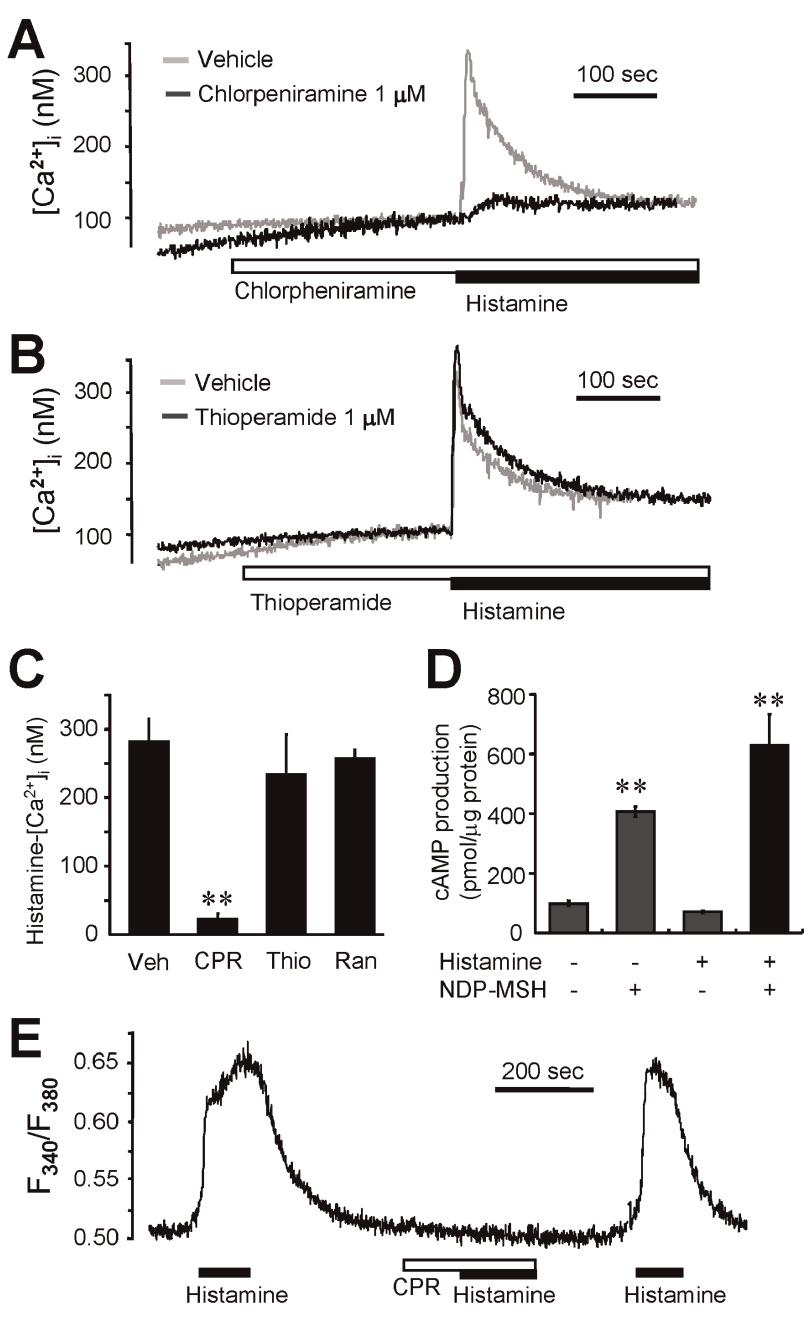
Figure 3. Histamine H1 inhibitor eliminates histamine-induced [Ca 2 + ]i rise in GT1-1 cells. (A–B) Fura-2-loaded GT1-1 cells were challenged with 100 m M histamine in the presence of 1 m M chlorpheniramine (A) and 1 m M thioperamide (B). Typical [Ca 2 + ]i traces from more than seven separate experiments are presented. (C) Cells were pretreated with vehicle (Veh), 1 m M chlorpheniramine (CPR), 1 m M thioperamide (Thio), or 30 m M ranitidine (Ran) before histamine (100 m M) treatment. The net increases in histamine-induced [Ca 2 + ]i are expressed with the mean 6 SEM. The experiment was independently performed three times. (D) Cells were stimulated with 1 m M NDP-MSH and/or 100 m M histamine (HA) in the presence of 5 m M Ro 20–1724 for 15 minutes; cAMP production was then monitored. Each point is the mean 6 SEM of a triplicate assay. The data are representative of three separate experiments. (E) Fura-2-loaded primary cultured rat hypothalamic cells were challenged with 100 m M histamine (black bar) in the presence or absence of 1 m M chlorpheniramine (CPR, white bar). Typical [Ca 2 + ]i traces from more than three separate experiments are presented. The results were reproducible. doi:10.1371/journal.pone.0036185.g003 and propranolol, specific antagonists for a - and b -adrenergic neurotransmitters, leading to the activation of a - and b -adrenergic receptors, respectively. Pre-incubation of the cells with propranolol receptors. To examine if the regulation of histamine signaling by (100 m M) (Fig. 4A) or prazosin (30 m M) (Fig. 4B) did not affect the desipramine is mediated by adrenergic receptors secondary to its inhibitory effect of desipramine (30 m M) on histamine-induced inhibitory effect on catecholamine reuptake, we applied prazosin